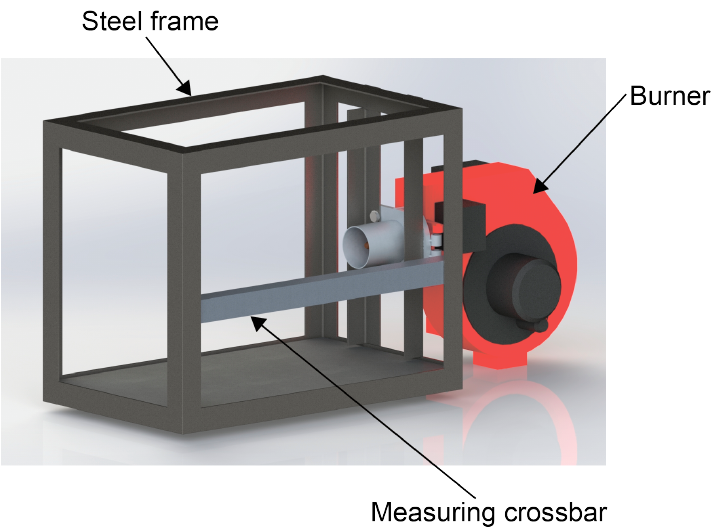
Figure 6. Experimental setup for measuring the heat flux during combustion: 1—metal frame; 2—burner; 3—crossbar with